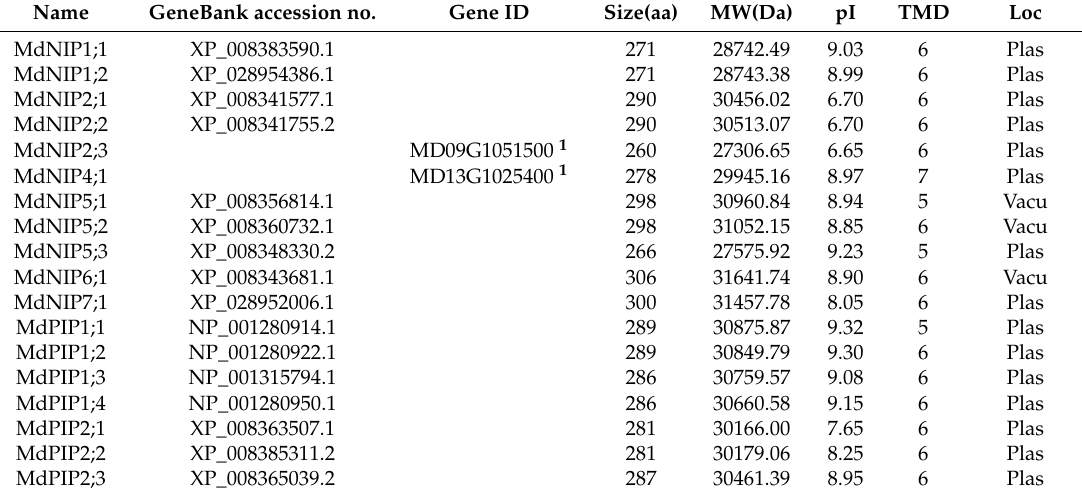
Table 1. The information of identified apple